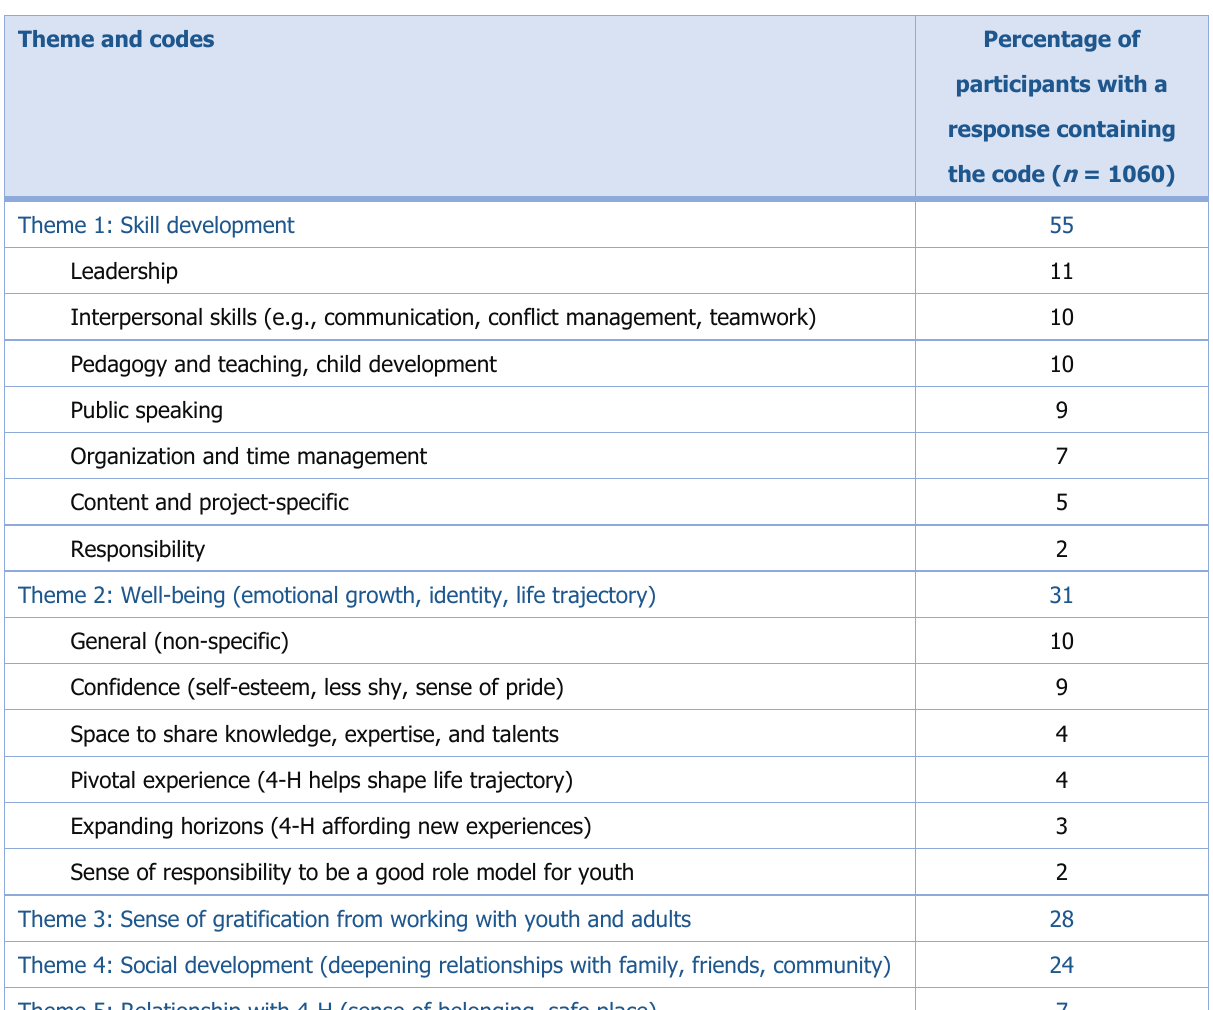
Table 3. Volunteer Outcome Themes Theme and